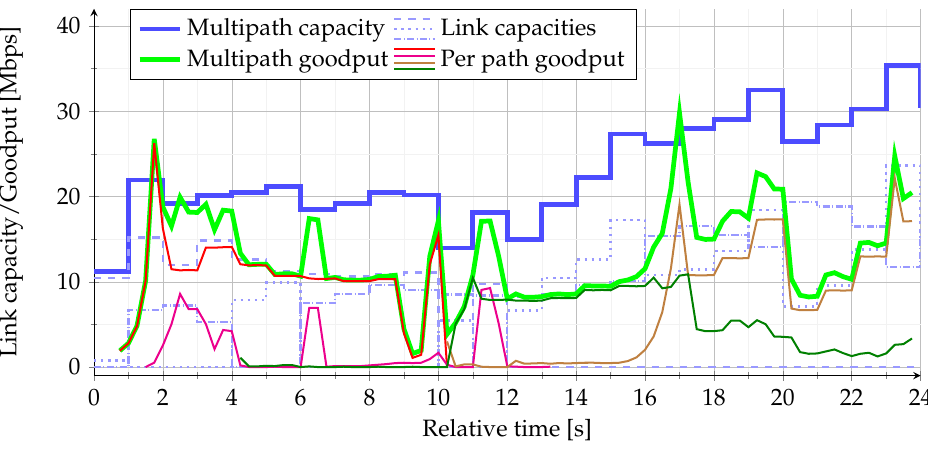
Figure 7. A measurement for Case 2, BBR CC. algorithm (line 9 of Table